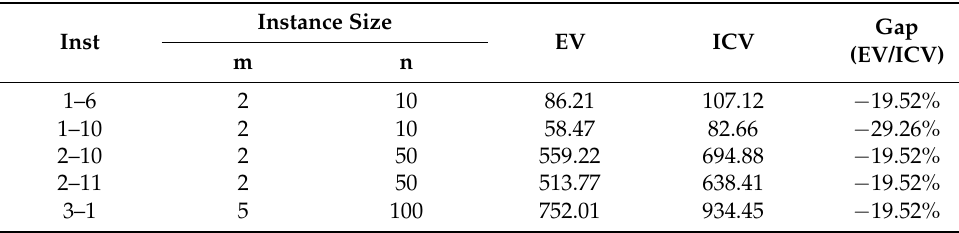
Table 6. Results of emissions of ICVs and EVs in the second